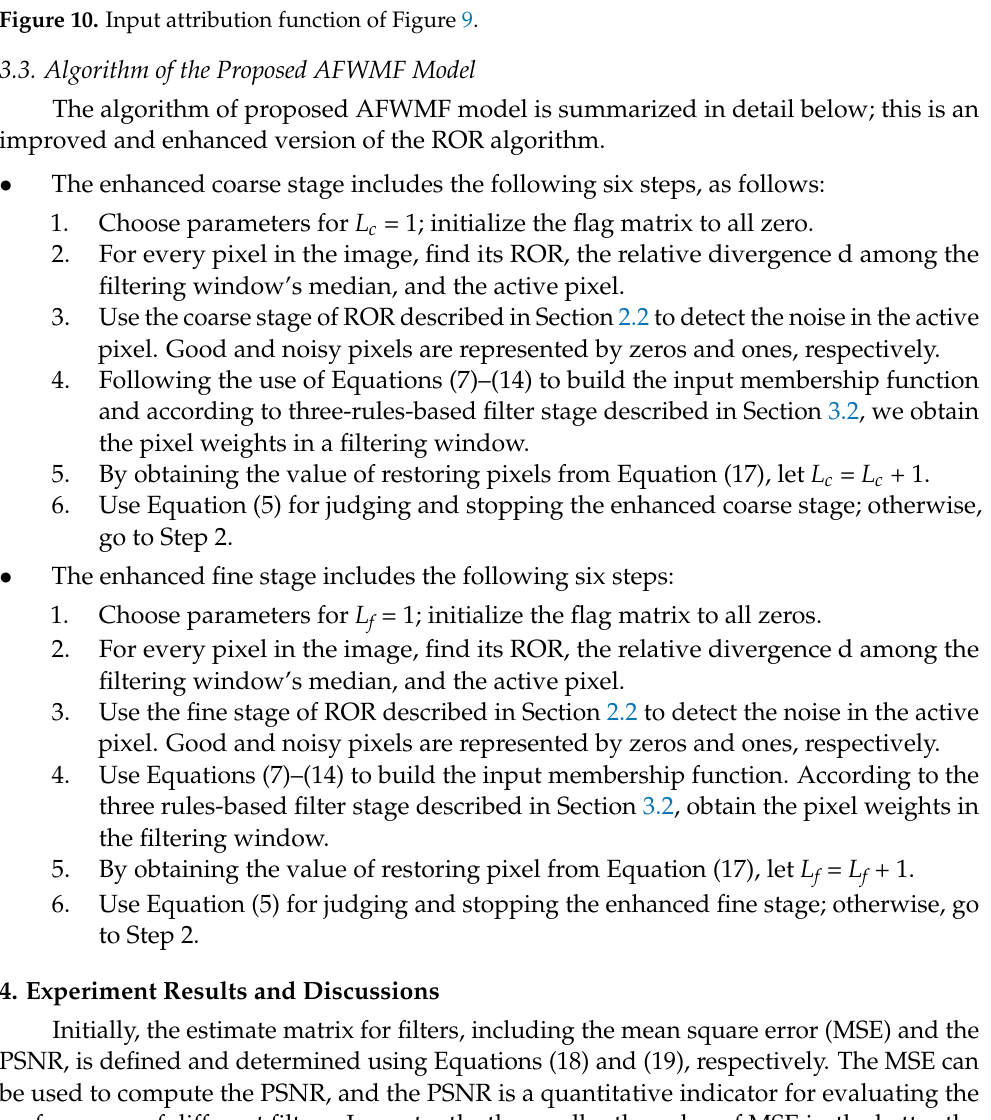
Figure 10. Input attribution function of Figure 9.